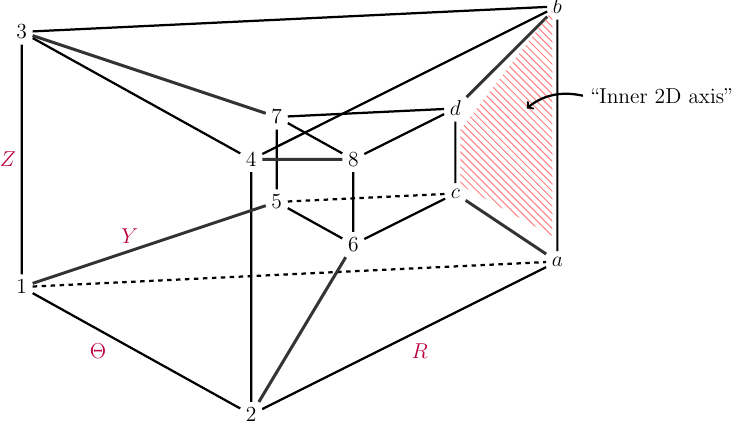
Figure 3 . A hyper-prism as a unit block for the discretization of the solid three-torus. The numbers 1 to 8 indicate vertices that are positioned on the outer boundary of the solid three-torus. The small latin letters a to d label vertices on the two-dimensional central axis. Table 1 lists all edges of the hyper-prism, together with their background lengths. Note that we have not included diagonal and hyper-diagonal edges in this